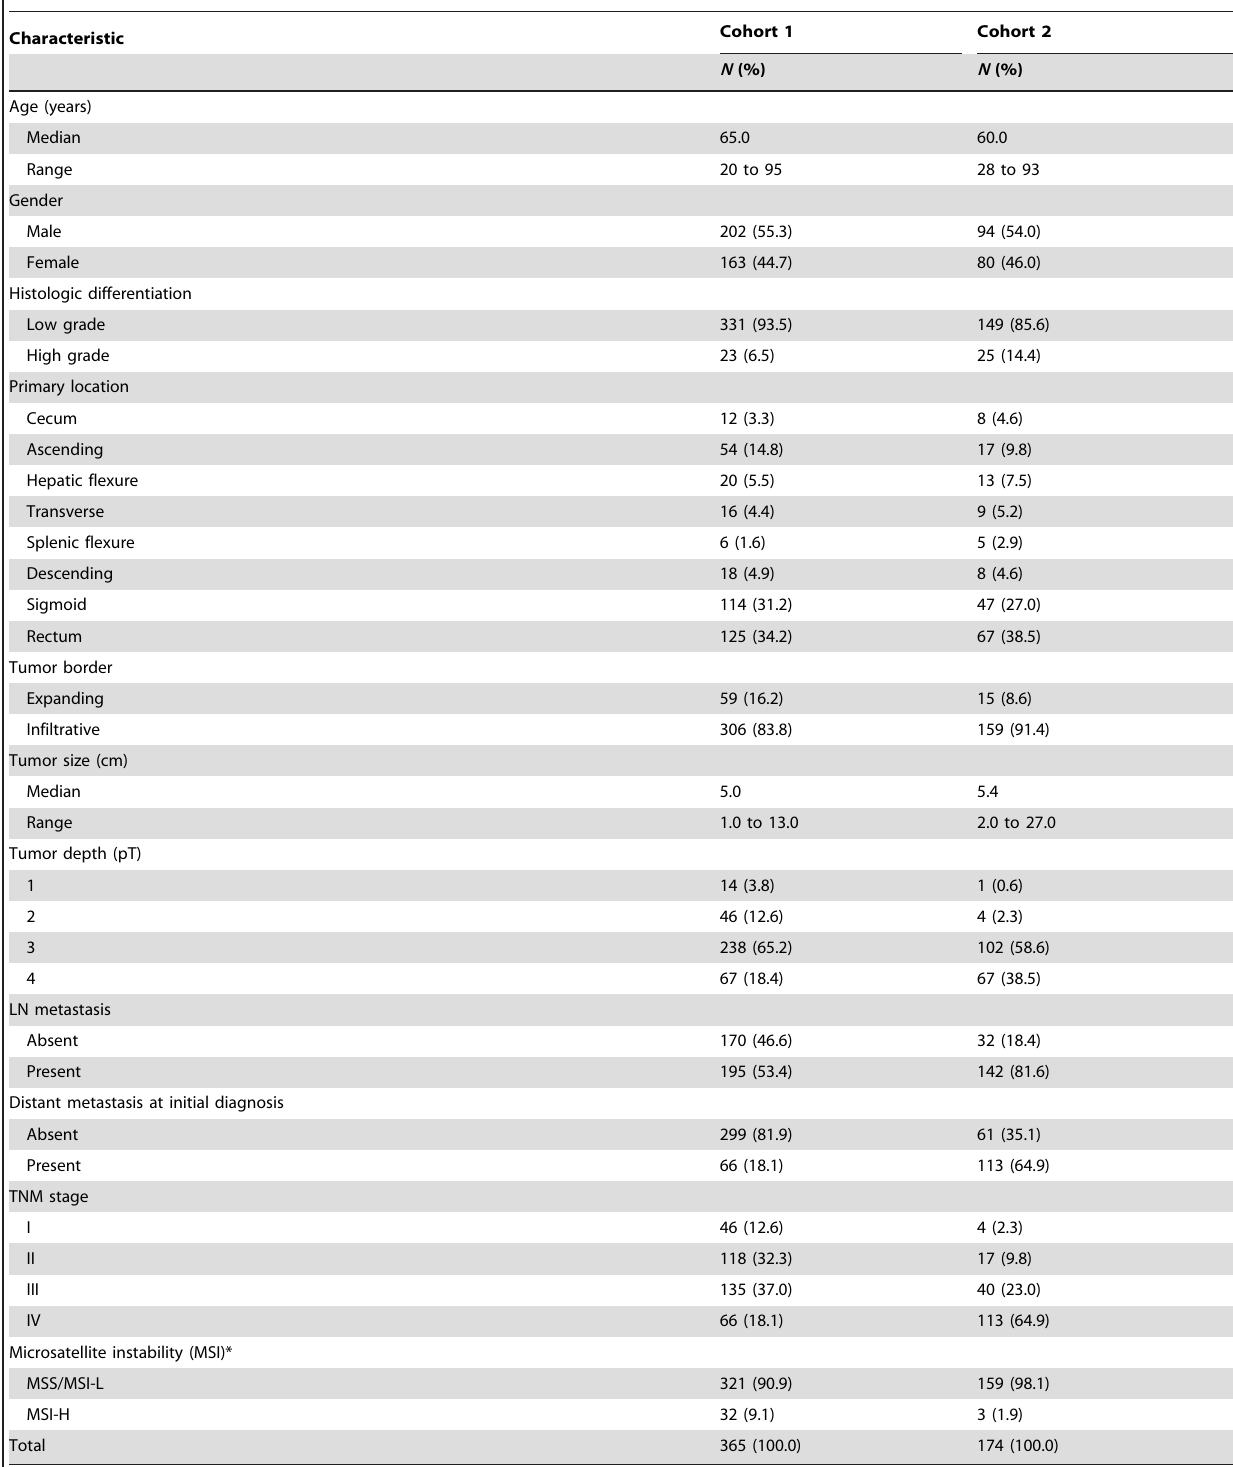
Table 1. Demographics and clinical characteristics of patients in each